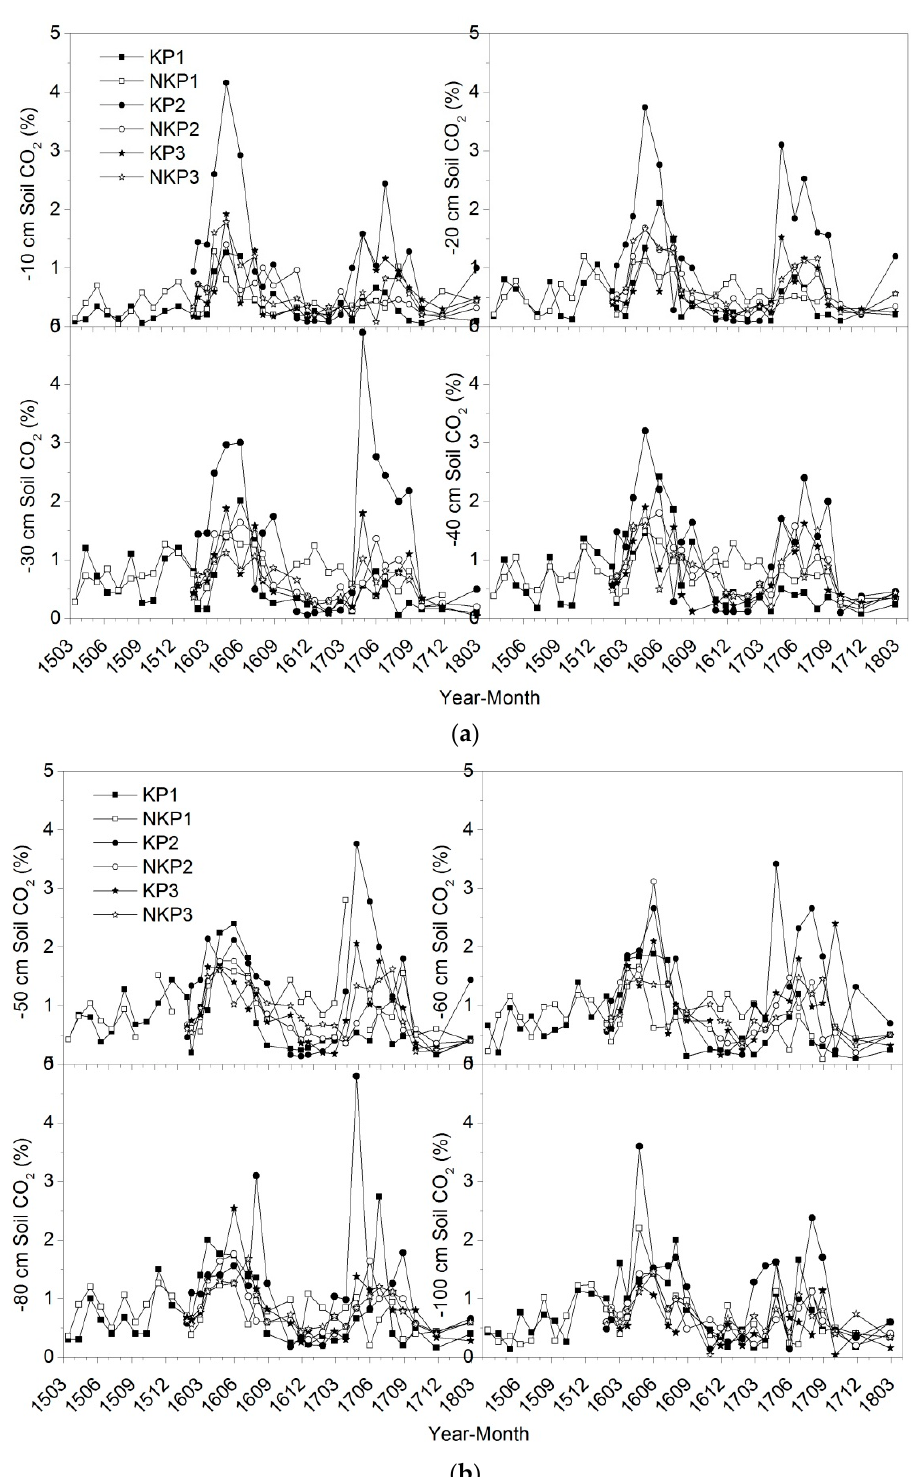
Figure 4. Soil CO 2 concentrations at 10 – 40 cm ( a ) and 50 – 100 cm ( b ) depths in calcareous and red soils. Soil CO 2 concentration in the calcareous soil and red soil profiles varied with depth, where it tended to be higher at 50–60 cm and lower in the upper and deeper layers; this pattern was clearer in the red soils (Figure 5). The mean CO 2 concentrations in the three calcareous soils were 11% greater than in the red soils (Table S2).